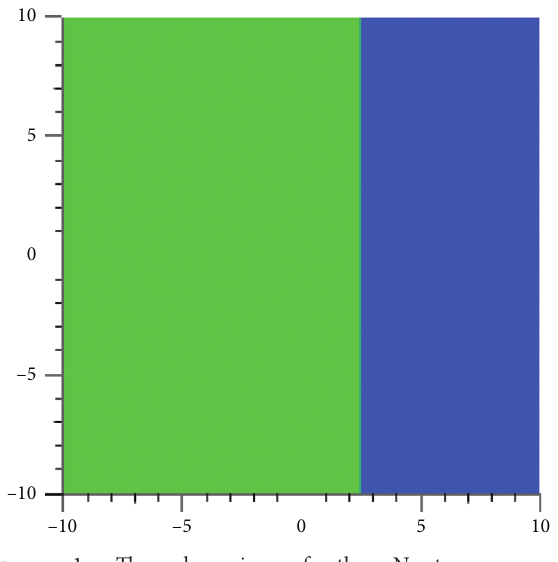
1: The dynamics of the Newton map of f ( z ) � ( z − 2 )( z − 3 ) , as discussed in Example 1.